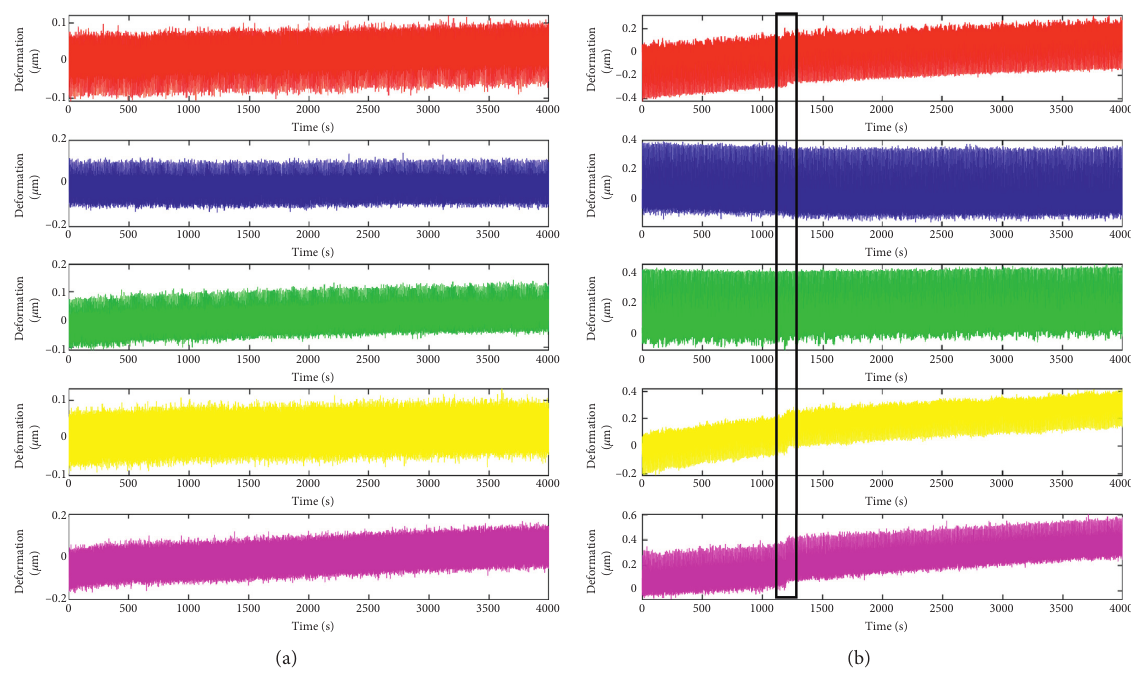
Figure 11: 4000s cycle loading test with the block on the left side. (a) On the top position. (b) On the low